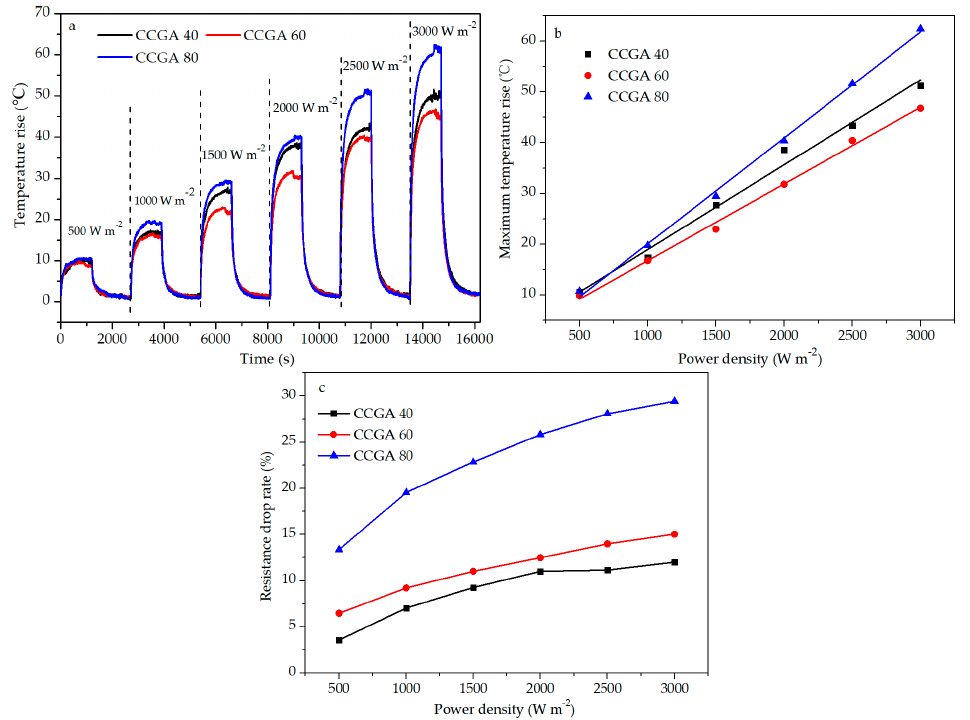
Figure 10. ( a ) Time-temperature rise curve of electrothermal CCGA with different NFC contents, ( b ) fitting curve between maximum temperature rise and power density of electrothermal CCGA with different NFC contents, ( c ) relationship between resistance drop rate-power density of electrothermal CCGA with different NFC contents. Table 3. Maximum temperature rise and resistance drop rate of electrothermal CCGA with di ff erent NFC contents under di ff erent power